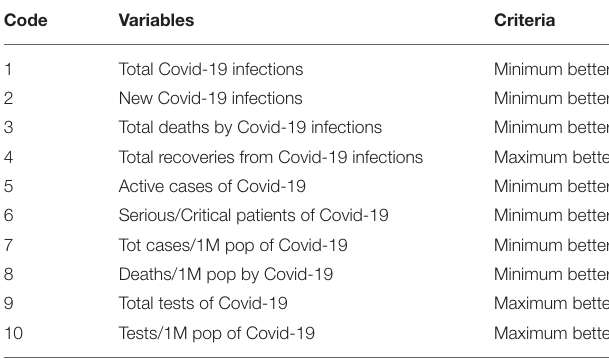
TABLE 1 | Specification of system